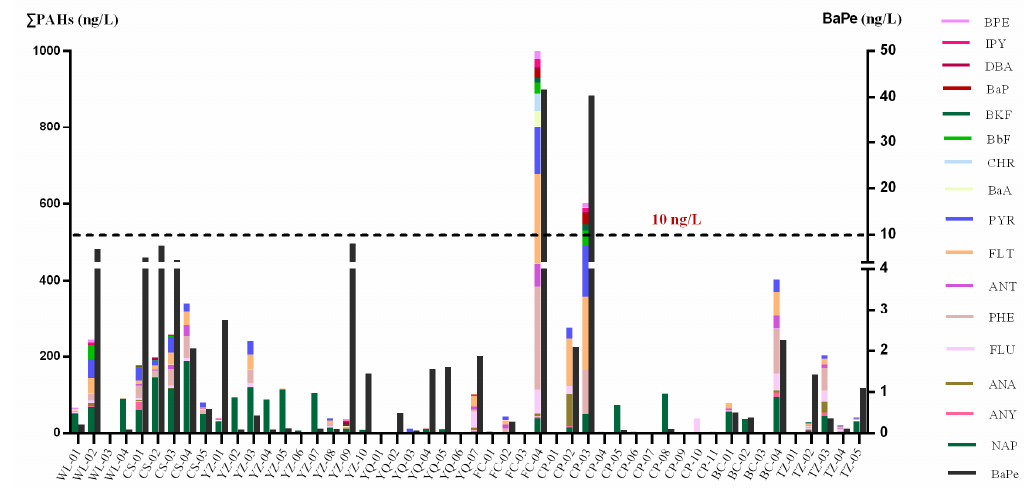
Figure 2. Concentrations and benzo[a]pyrene equivalent concentrations of PAHs in the groundwater samples.